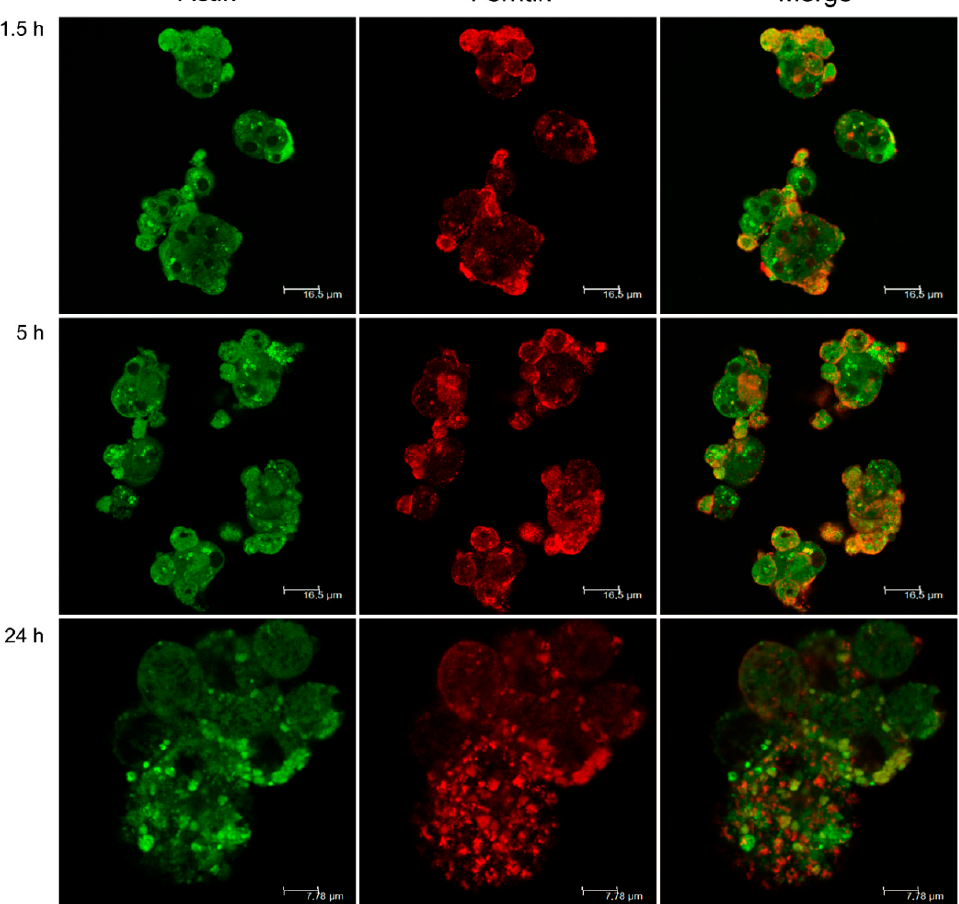
Figure 2. Actin and ferritin of hepatocyte aggregates exposed to L. infantum promastigotes. 3D-culture samples obtained at 1.5, 5, and 24 h of parasite exposure were stained with actin antibody conjugated with FITC and anti-ferritin antibody was conjugated with Alexa Fluor 647. Aggregates were observed under a confocal fluorescent microscope, and images were acquired. The density of actin vesicles (green) increased after 24 h of exposure to the parasite, and ferritin (red) deposits increased after 5 h of parasite exposure followed by a decrease after 24 h of exposure to promastigotes. Black spots—hepatocyte